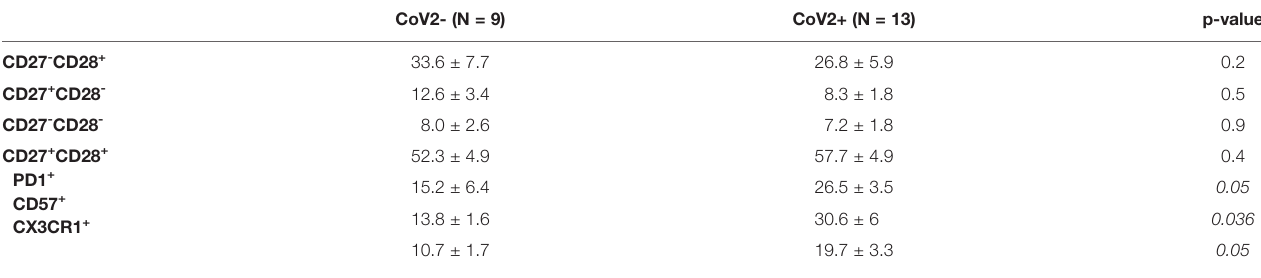
Statistical signi fi cant values are